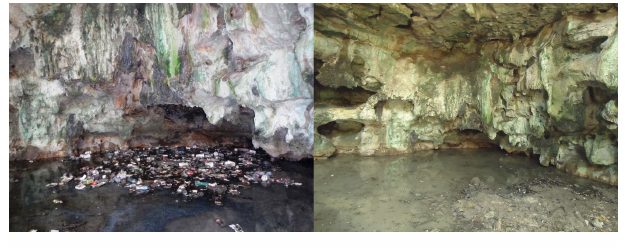
Fig. 1 . Cenotes in Yucatan suffer from poor solid